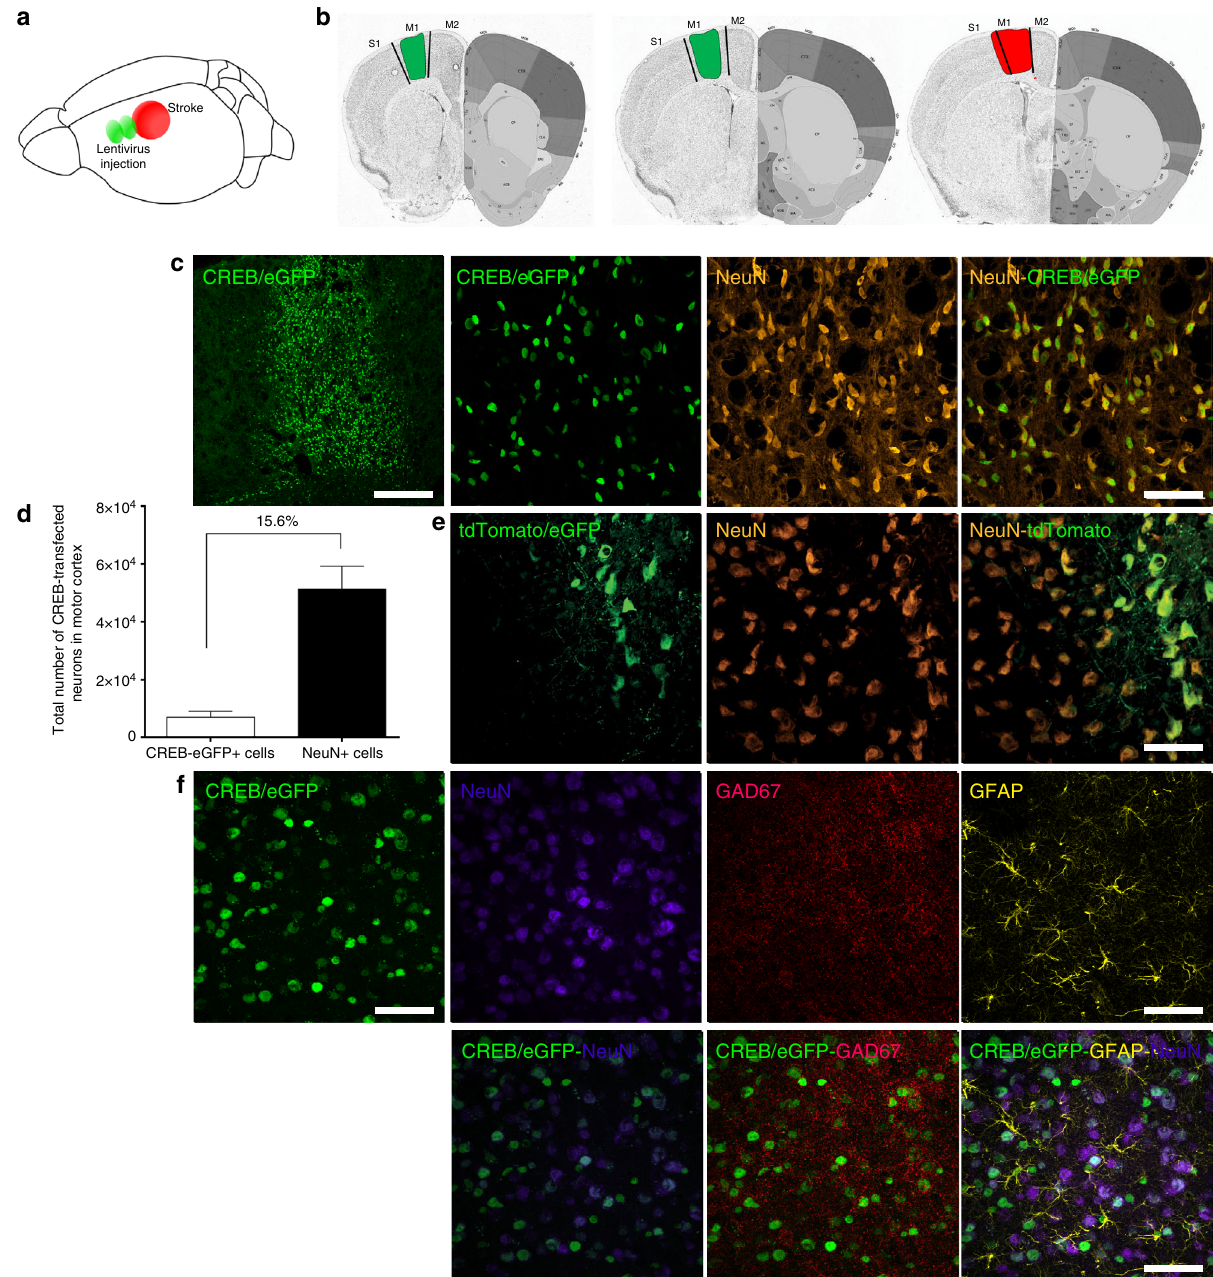
Fig. 1 Lentiviral CREB expression in cortical pyramidal neurons. a Schematic shows location of stroke area (red) and two lentivirus injections (green) in the peri-infarct area. b Atlas-based 22 schematic of location of lentivirus injection (green) and stroke (red). c Left: Lenti-CREB-eGFP in peri-infarct cortex at the time of stroke, 7 days after injection and after stroke induction. Transfected cells form a column in cortex. Top is the pial surface, bottom is the white matter. Scale bar = 300 μ m. Right panels: CREB-eGFP staining (green, infected cell) in peri-infarct tissue, co-localize with NeuN staining (orange) 4 weeks after stroke. Scale bar = 50 μ m. d Stereological quanti fi cation of motor cortex CREB-induced cells (CREB-eGFP + cells) relative to the whole motor cortex neuronal pool (NeuN + cell ± SEM). n = 4 (eight brain sections for each mouse). e Immunohistochemical staining in peri-infarct M1 in mice transfected with control virus (green, tdtomato-eGFP) overlapping with NeuN staining (orange) 4 weeks after stroke. Scale bar = 50 μ m. f Left: immunohistochemical staining in peri-infarct M1 in mice transfected with Lenti-Creb-eGFP (green) overlapping with NeuN staining (purple); Middle: immunohistochemical staining showing inhibitory neurons (GAD67, glutamate decarboxylase 67); Right: immunohistochemical staining showing that there are very rare Lenti- CREB infected cells that double stain for GAD67, 4 weeks after stroke. Scale bar = 100 μ m. M1 primary motor cortex, M2 secondary motor cortex, S1 primary somato sensory